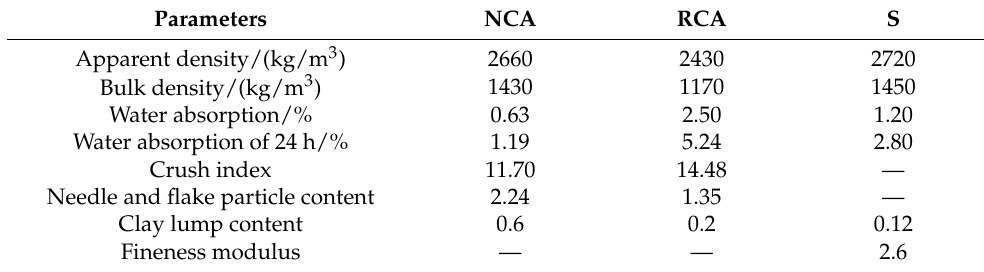
Figure 1. Gradation of coarse aggregate. Table 2. Physical properties of aggregates.